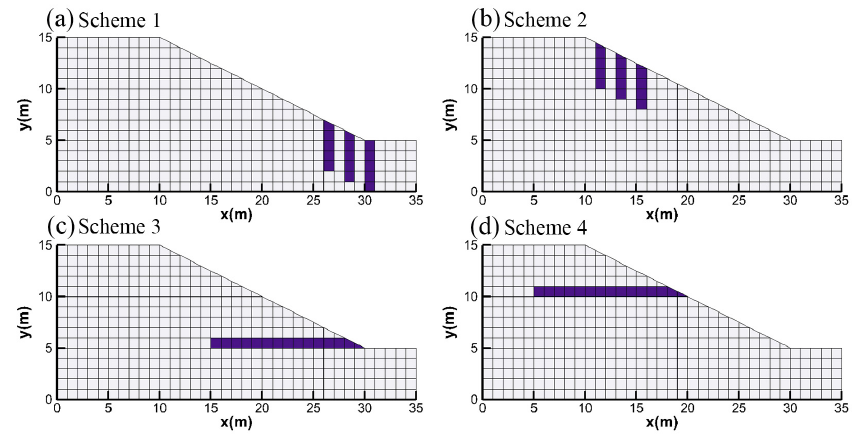
Figure 10. Borehole locations of four sampling schemes.